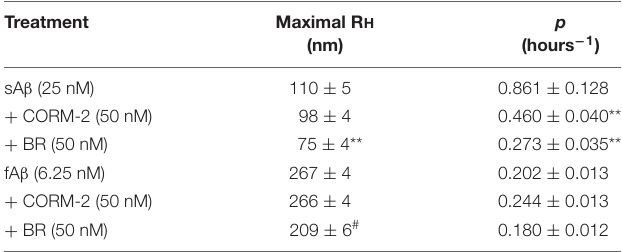
TABLE 1 | Effects of carbon monoxide donor CORM-2 and bilirubin (BR) on β -amyloid (A β ) aggregation. Treatment Maximal R